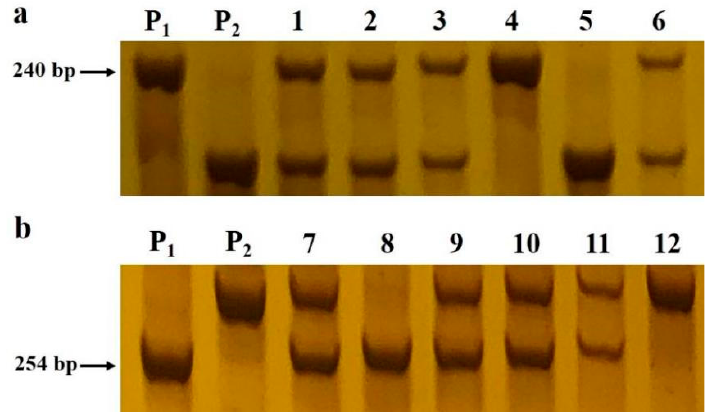
Figure 3. Experimental results of polymorphic markers Indel-78 and Indel-15. Marker scan with progeny BC 5 F 3 and BC 6 F 2 populations derived from the parents ZS11 and NJAU5773 was con- ducted. P 1 and P 2 indicates PCR products from the parents ZS11 and NJAU5773 plants, respectively. ( a ) Shows partial results for InDel marker Indel-78 in which 1–3 and 6 denote the PCR products from the heterozygous plants in the progeny populations, and 4 and 5 denotes products from the homozygous plants with flatten leaves and upright siliques and plants with up-curling leaves and downward-pointing siliques, respectively. ( b ) Shows partial results for InDel marker Indel-15 in which 7 and 9–11 denote the PCR products from the heterozygous plants in the progeny popula- tions, and 8 and 12 denotes products from the homozygous plants with flatten leaves and upright siliques and plants with up-curling leaves and downward-pointing siliques, respectively.